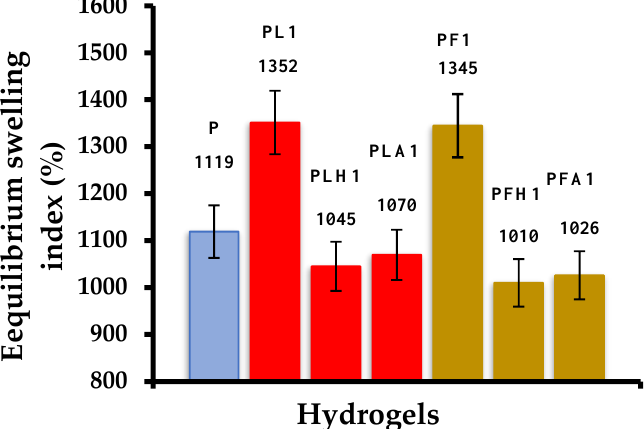
Figure 21. Comparison of equilibrium swelling indices of hybrid hydrogels synthesized from un- modified and modified inorganic phases.